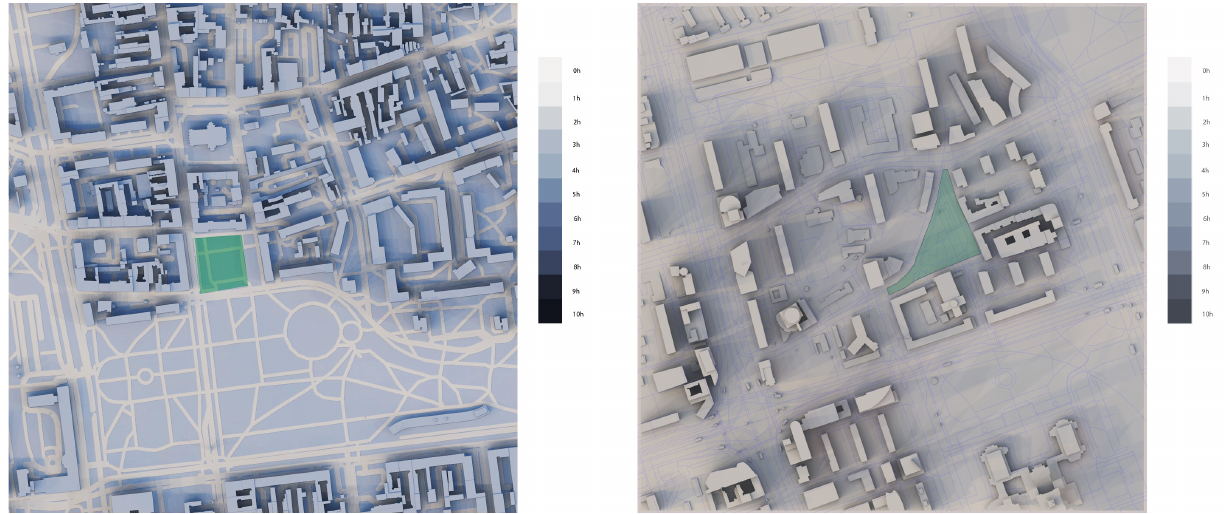
Figure 5. Analyses of the shading of the area and surroundings of Old Market Square in Lodz (left) and Grzybowski Square in Warsaw (right) on March 20, June 21, and September 22. The legend shows the number of hours of